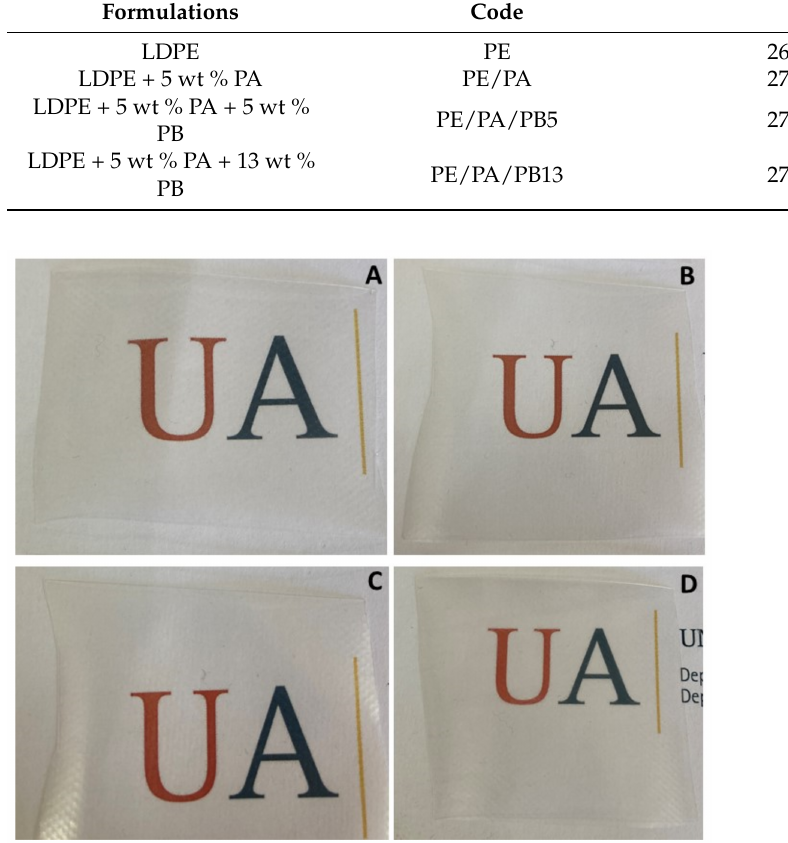
Figure 1. Visual appearance of neat PE ( A ), PE/PA ( B ), PE/PA/PB5 ( C ) and PE/PA/PB13 ( D )